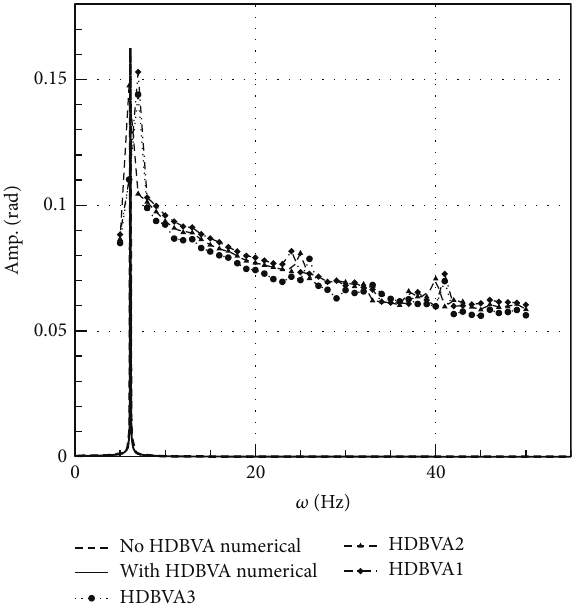
Figure 26: Frequency response of 𝜃 𝑍 DOF of case Figure 10(a), HDBVAs start at the far-from-force point.